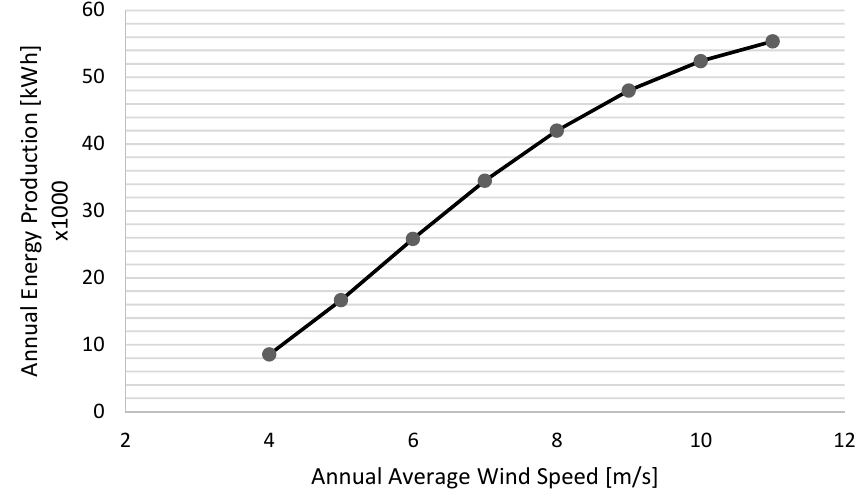
Figure 7. Estimated Annual Energy Production for a 10 kW 3-blade, upwind, horizontal axis wind turbine (reference air density: 1.225 kg/m 3